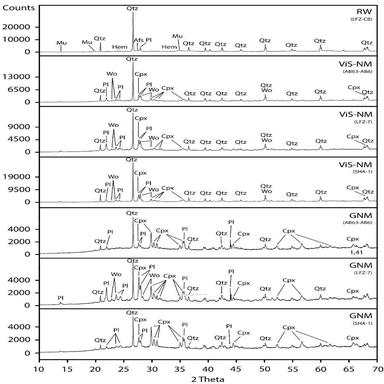
Powder XRD patterns of selected samples from the raw/low fired samples, the ViS-NM zone and GNM zone. Abbreviations: Qtz = quartz, Mu = muscovite; Hem = hematite; Afs = alkali feldspar; Pl = plagioclase; Wo = wollastonite and Cpx = clinopyroxene (overview of all XRD-data see S.I.2).